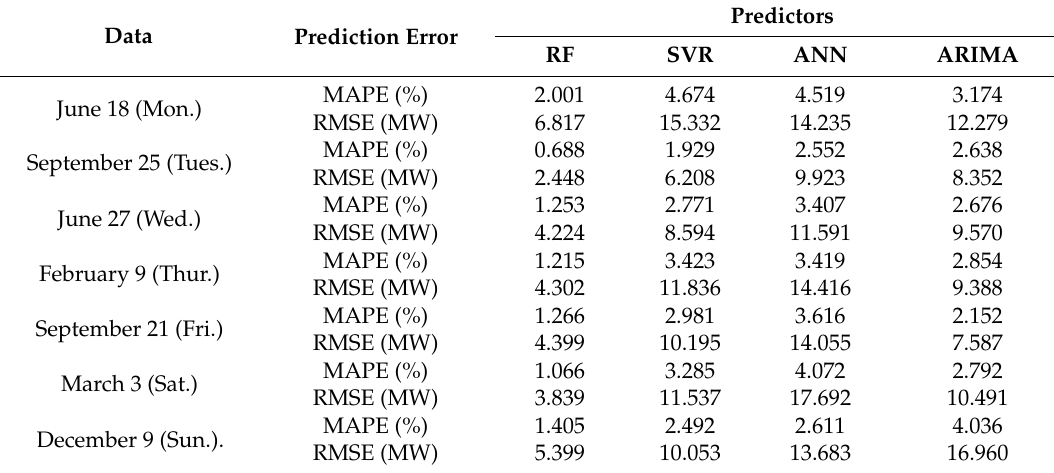
Table 13. Prediction error of different predictors of the selected seven test days when day-ahead prediction is conducted.